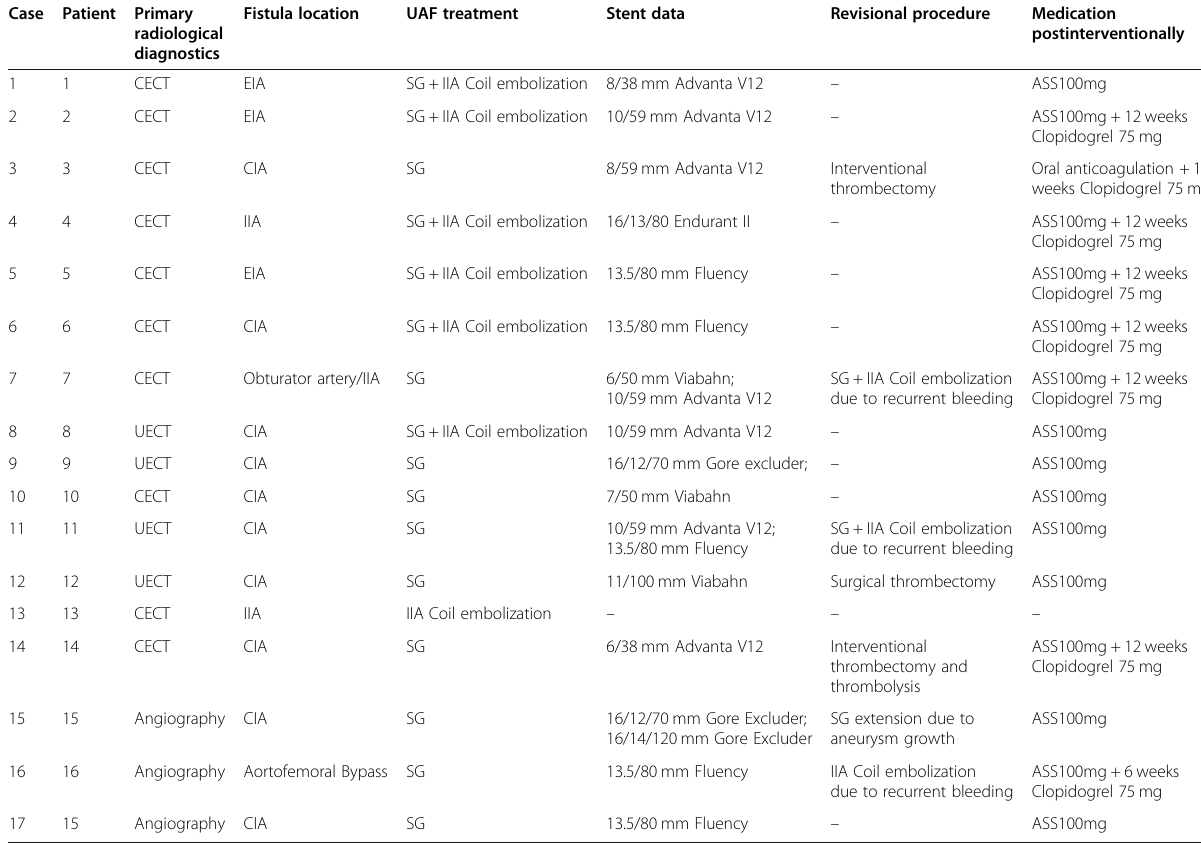
Table 3 Technical data and procedures Case Patient Primary